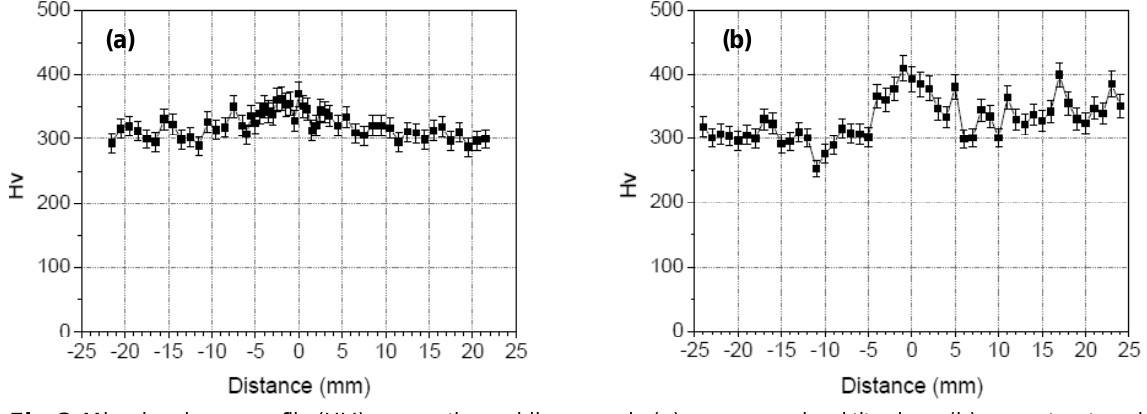
Fig. 3. Microhardness profile (HV) across the welding zone in (a) coarse-grained titanium; (b) nanostructured titanium processed by ECAP.